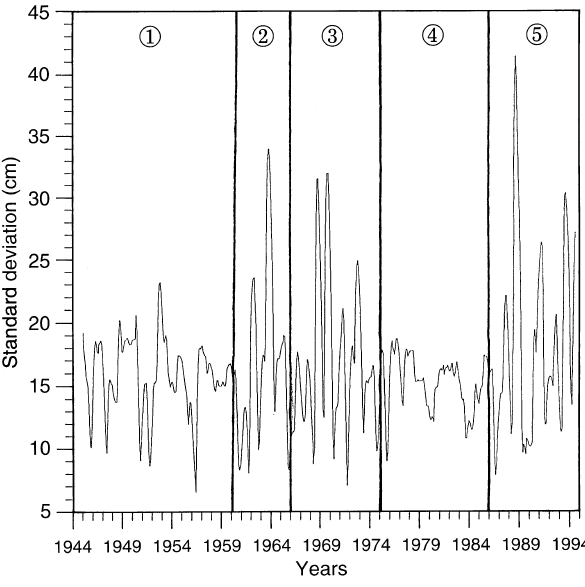
Fig. 13. Twelve monthly moving averages of the